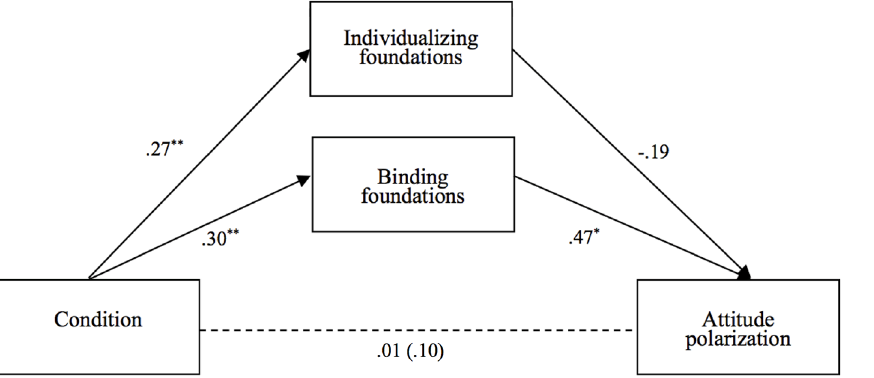
Figure 1. Indirect effect of Condition (moral vs practical) on attitude polarization via both indices of moral expressiveness (coding: Moral = 1, Practical =